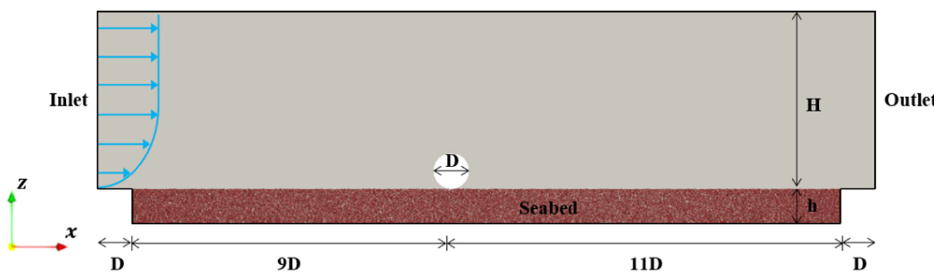
Figure 1. Computational domain for pipeline scour.